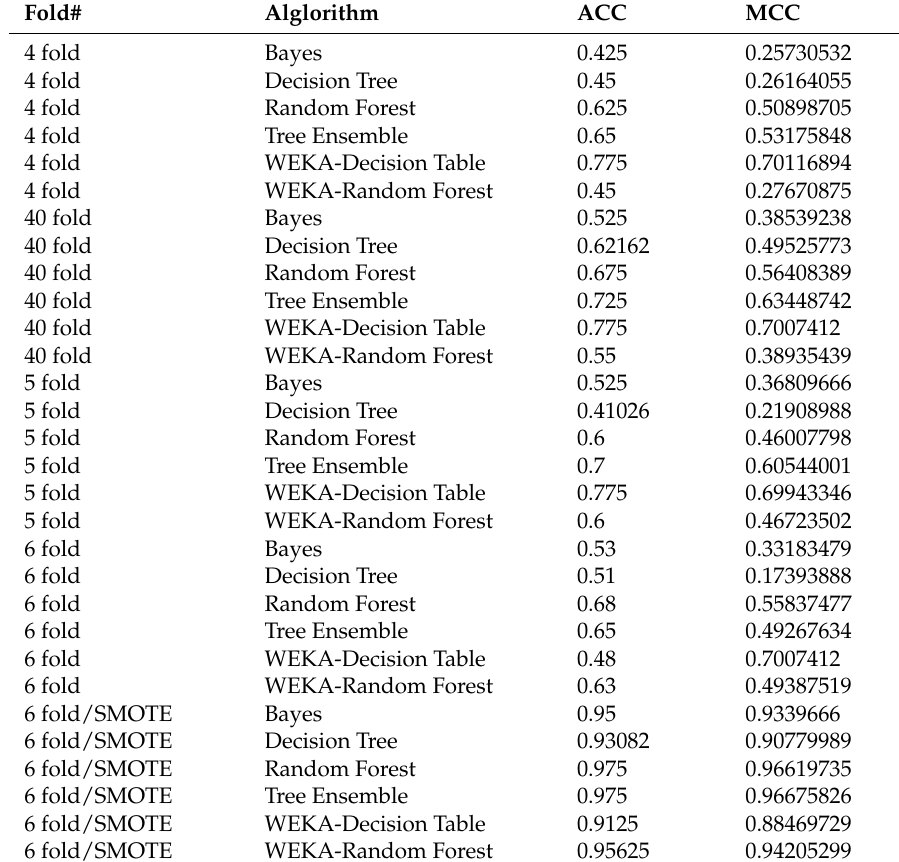
Table B1. Comparison of different classifiers with accuracy (ACC) and Matthews correlation coefficient (MCC) for different classifiers.